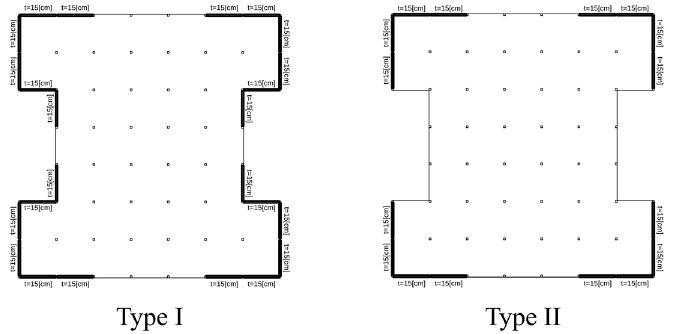
Figure 1. Concrete shear walls: two types of wall distribution (Case 1).